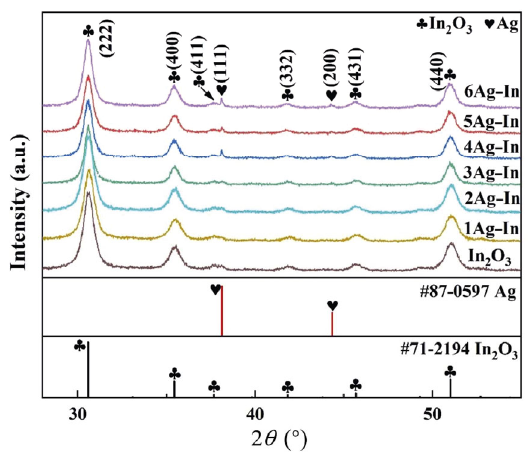
Fig. 3 XRD patterns of In 2 O 3 , 1Ag–In, 2Ag–In, 3Ag–In, 4Ag–In, 5Ag–In, and 6Ag–In.